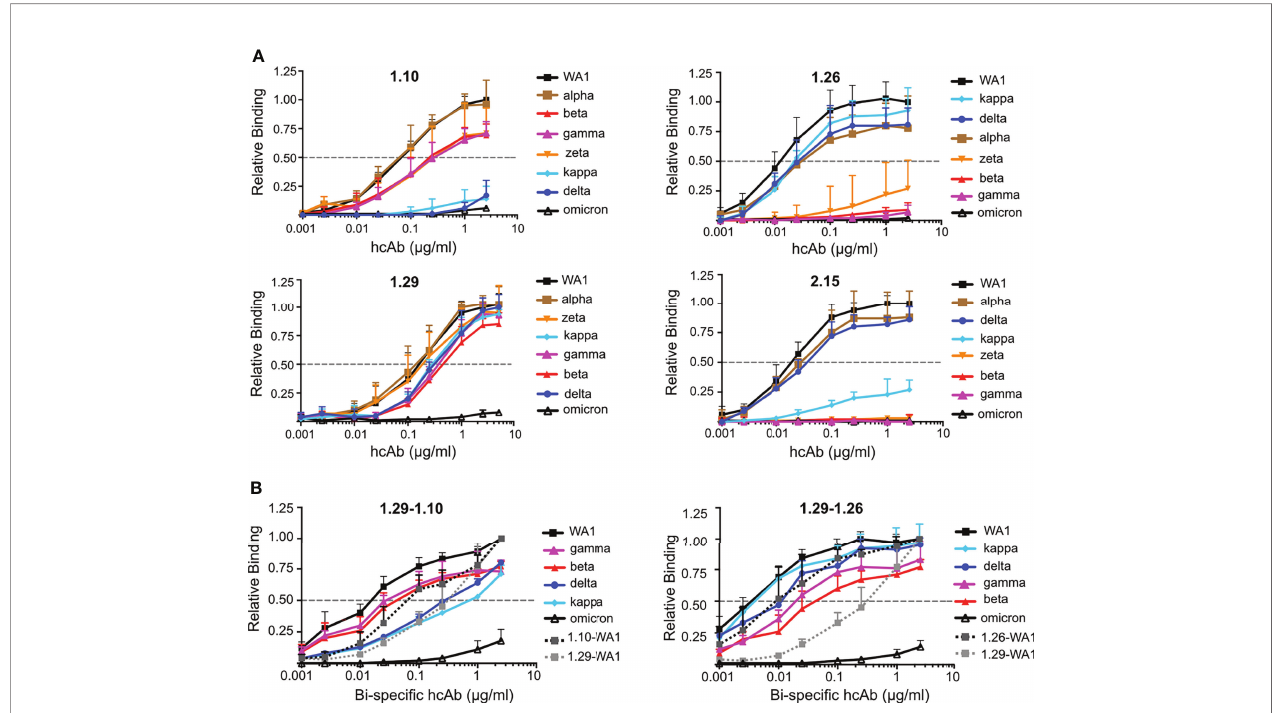
FIGURE 7 | Monospeci fi c and bispeci fi c hcAb recognition of RBD variants. (A) Binding of hcAbs 1.10, 1.26, 1.29 and 2.15 (indicated on top of each graph) to RBD-Fc protein variants, which are shown and color coded on the right of each graph; listed from higher (top) to lower (bottom) hcAb binding activity. The OD 490 determined with serial hcAb dilutions as in Figure 1 was normalized to the maximum binding signal with the WA1 protein. The dotted line represents half of the maximum hcAb binding to WA1 RBD-Fc, used to determined EC 50 values. Mean and standard deviation (SD) of at least three independent assays (n ≥ 3). (B) Binding of bispeci fi c hcAbs 1.29-1.10 and 1.29-1.26 carried out as in (A) Binding of the monospeci fi c hcAbs 1.29, 1.10 or 1.26 to the WA1 RBD are also shown for direct comparison with the bispeci fi c hcAbs. Data are mean and standard deviation (SD) of three independent assays (n =